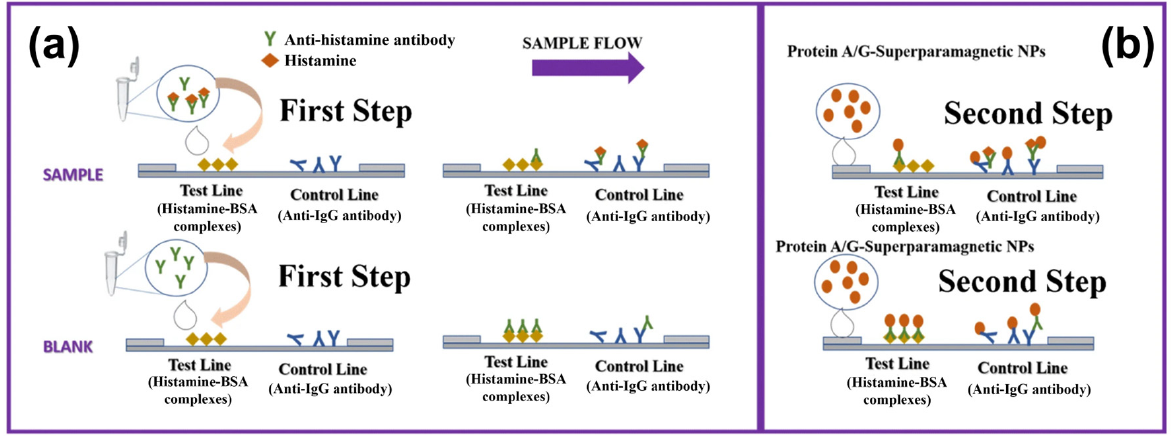
Figure 14. Illustration of the lateral-flow immunoassay in dipstick format developed by Moyano et al. for histamine quantification in red wine samples [245]. ( a ) In the first step, the sample is mixed with a given amount of antihistamine antibodies: Free antibodies are captured at the test line coated with histamine–BSA complexes, histamine–antibody complexes proceed to the control line, where they bind to anti-IgG antibodies. ( b ) In the second step, all antibodies are labeled by gold- or magnetite nanoparticles tethered to the antibodies via the A/G protein. The signal, measured by impedance electrodes underneath the test line, is inversely proportional to the histamine contents of the original sample. Figure reprinted with permission by Springer from ref. [245], published in Analytical and Bioanalytical Chemistry , Copyright 2019.